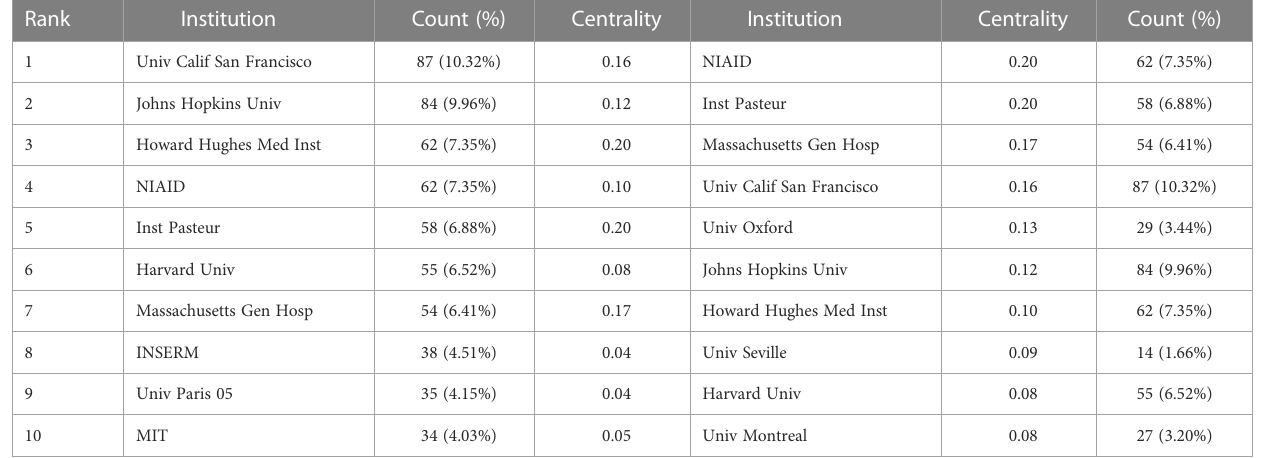
TABLE 2 The top ten institutions with the most publications (left sides) and betweenness centrality (right sides). Rank